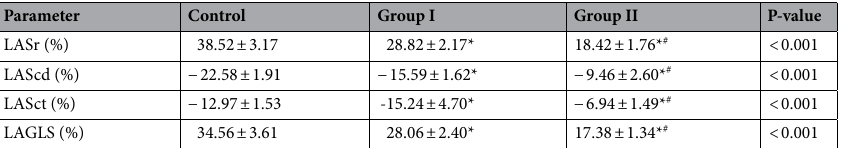
Table 4. Strain analysis. Data are presented as mean ± standard deviation. LASr strain during reservoir phase, LAScd strain during conduit phase, LASct strain during contraction phase, LAGLS left atrial global longitudinal strain. *Compared with control group, P < 0.05. # Compared with group I, P < 0.05.